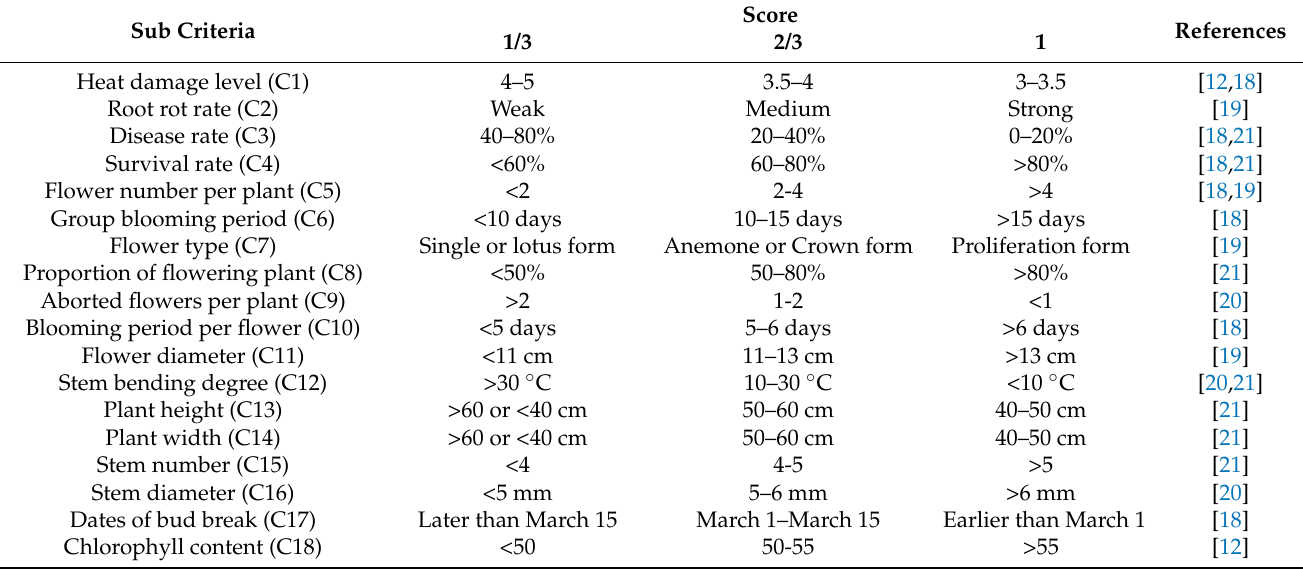
Table 9. Rating scale of all